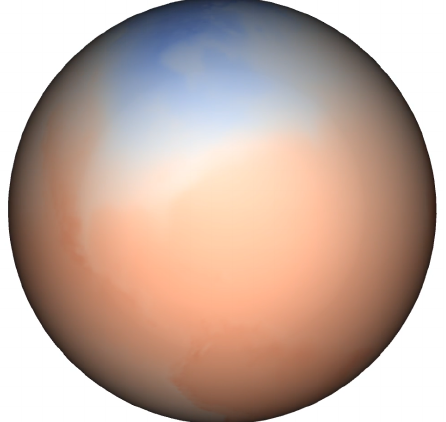
Figure 18. Temperature data interpolated across the DT Discrete Global Grid System (DGGS). Cold areas are blue and red areas are hot. This data can be queried and visualized across the Earth in real